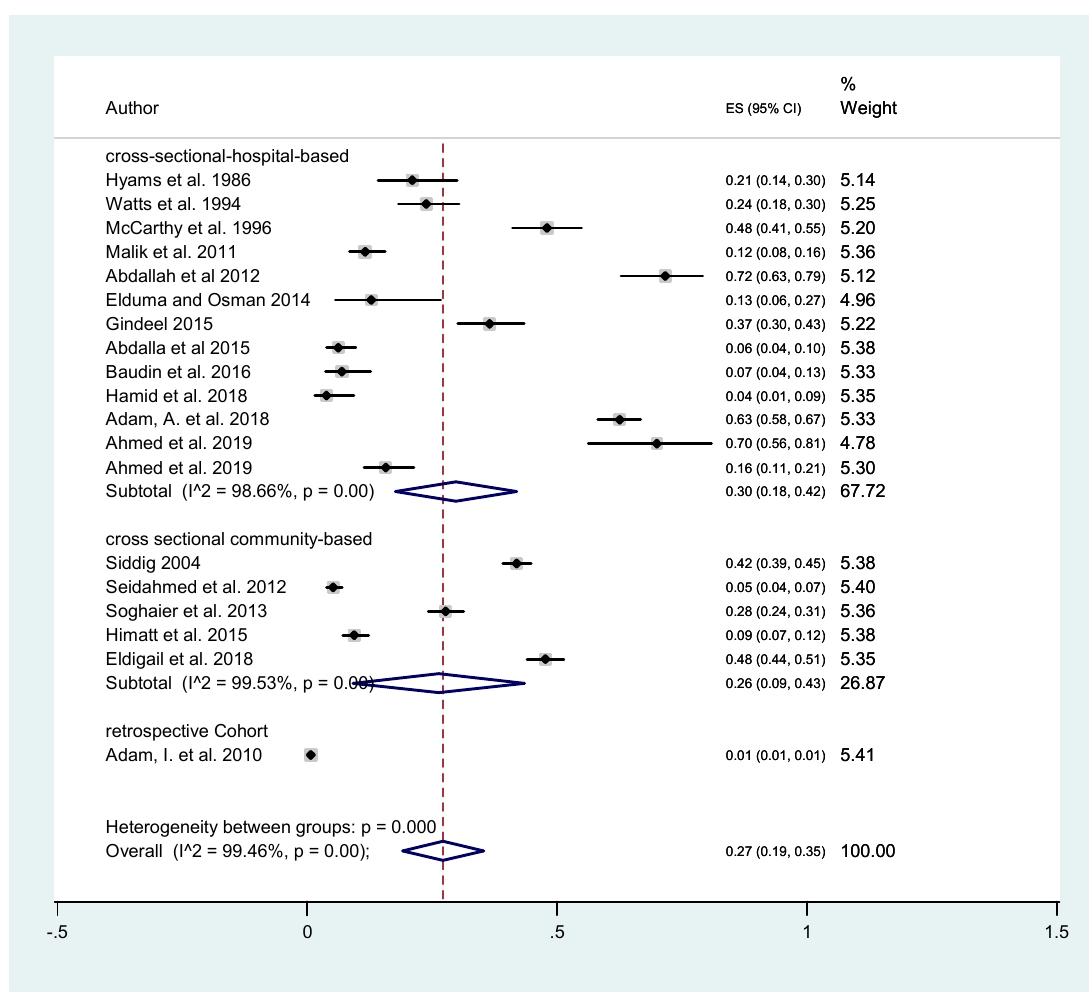
Figure 4. The estimated burden of dengue based on sub-group analysis according to study design.